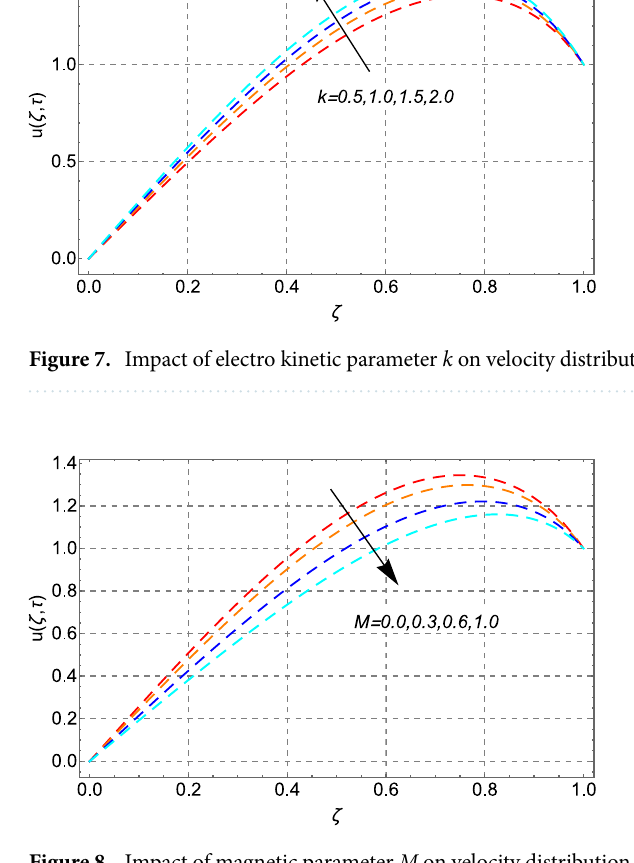
Figure 8. Impact of magnetic parameter M on velocity distribution.